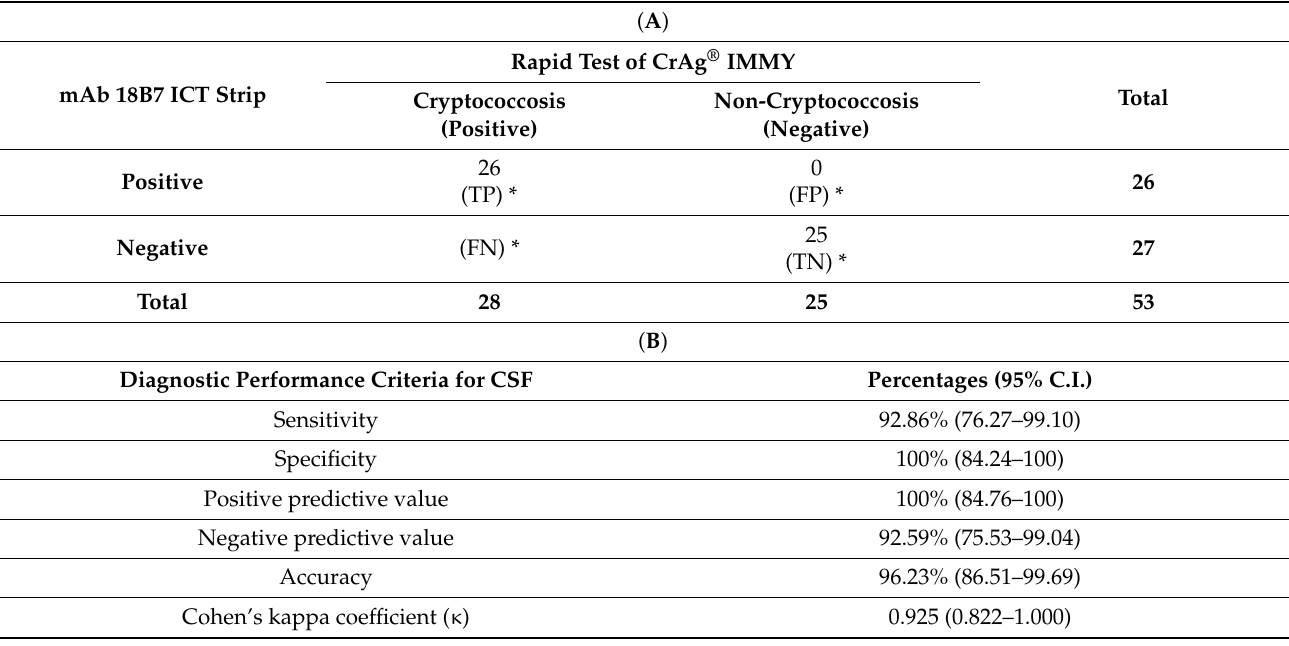
Table 3. ( A ) Two by Two table for diagnostic performance of mAb 18B7 ICT strip against CSF samples compared with